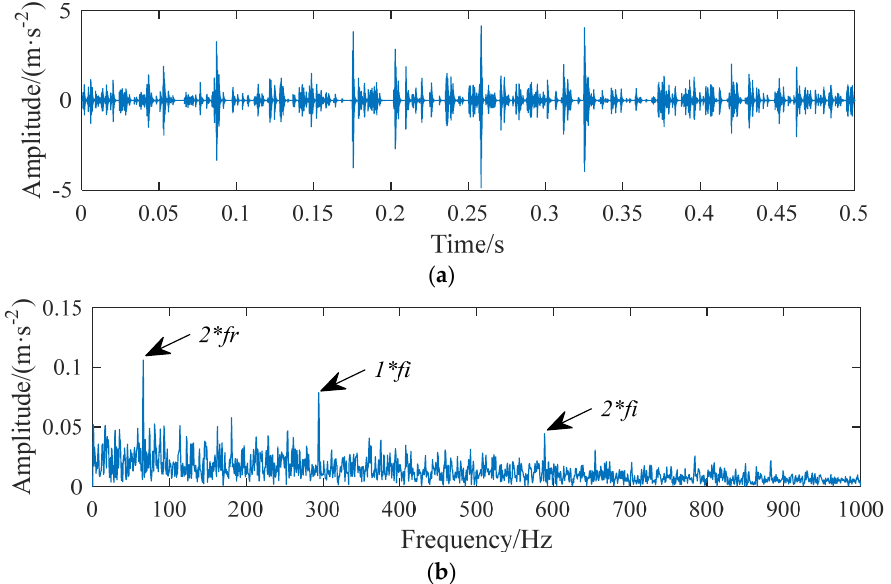
Figure 19. The result of the 2056th set of data processing based on LWDFSS ‐ AEWT algorithm: ( a ) Waveform of reconstructed signal; ( b ) Envelope spectrum of the reconstructed signal.